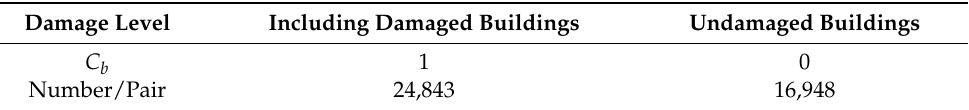
Table 6. The statistics of building data set.